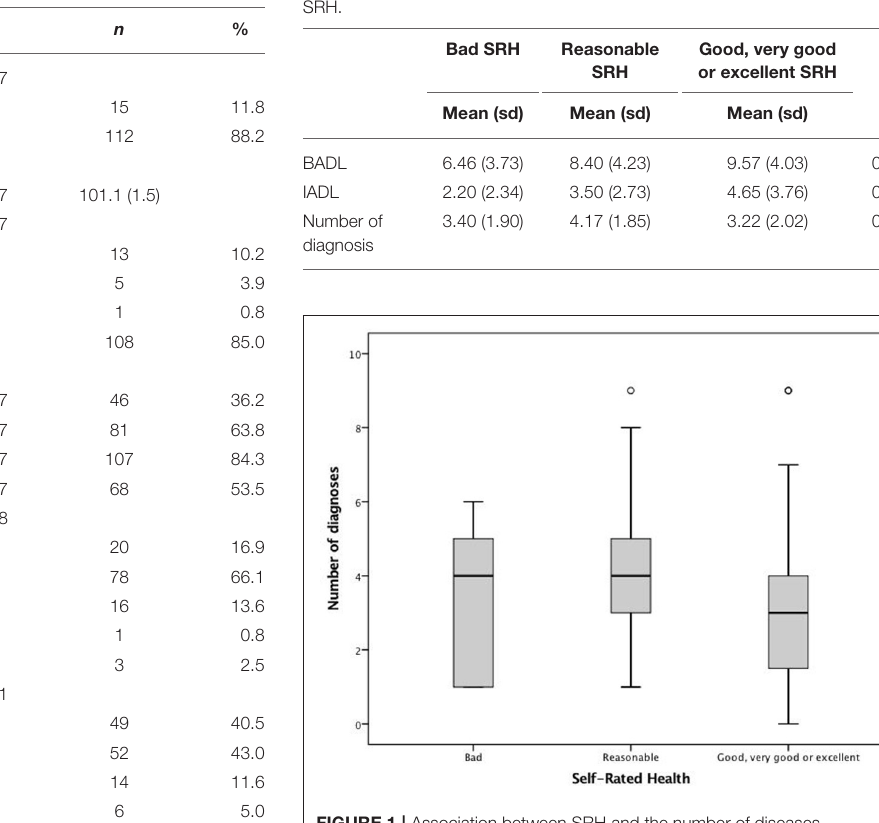
TABLE 1 | Sample characteristics.